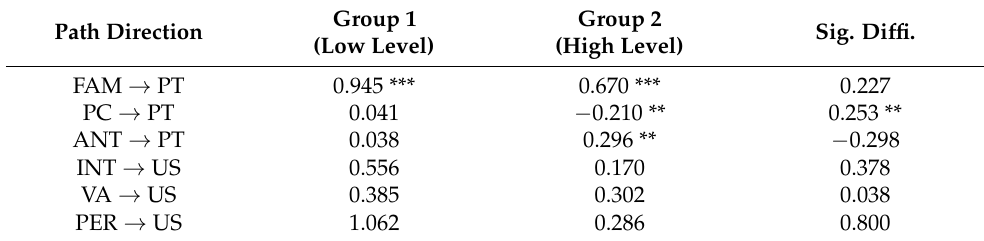
Table 8. The results of multigroup analysis (educational